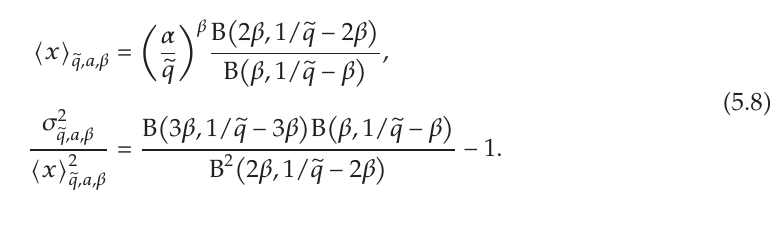
(cid:2) a (cid:8) n − 1 (cid:3) ! (cid:2) a − 1 (cid:3) !